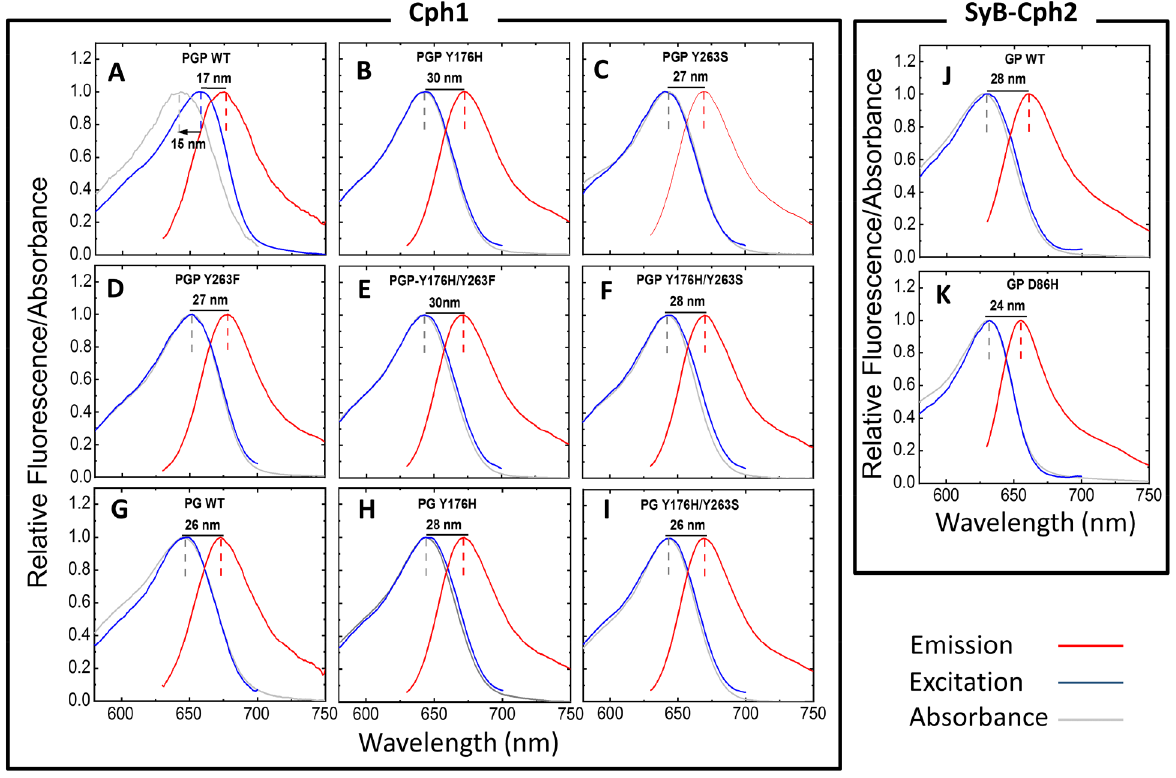
Figure 3. Steady-state absorption, excitation, and emission spectra of Cph1 and SyB-Cph2 variants. The absorption (ab), excitation (ex) and emission (em) spectra are shown in grey, blue, and red, respectively. Cph1 PGP WT and variants are shown in A to F, Cph1 PG WT and variants in G to I, and SyB -Cph2 GP WT and its variant in J and K. The Stokes shift (λ max(em) − λ max(ab) ) is indicated. The blue shift between maximum excitation and absorption wavelength (λ max(as) − λ max(ex) ) is indicated in A. The values are summarised in Table 1. Conditions as in Fig.